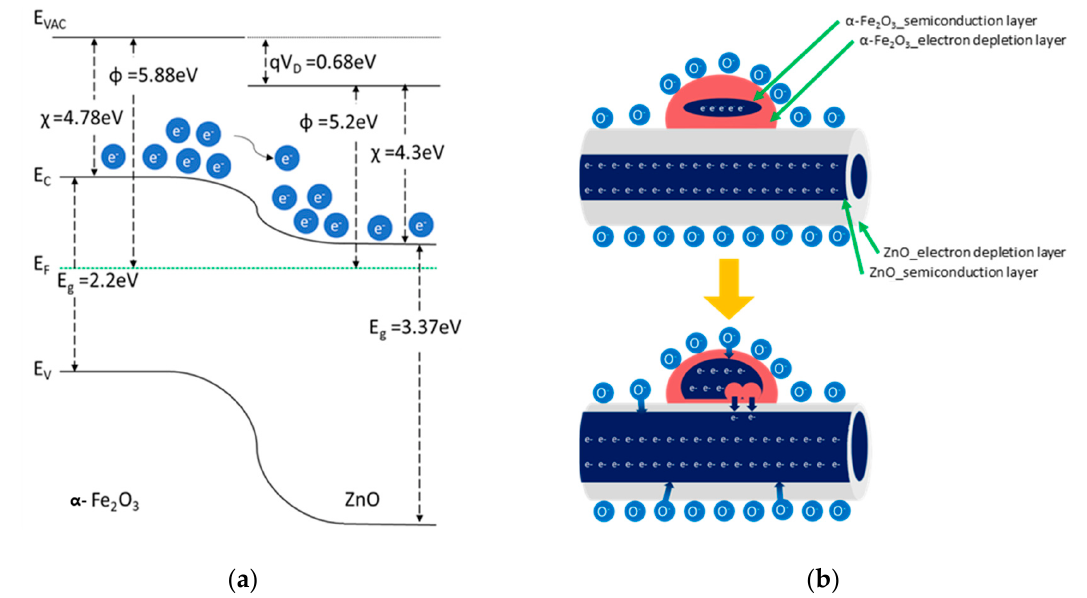
Figure 5. Improvement in gas sensor response: ( a ) energy diagram of α -Fe 2 O 3 / ZnO heterojunction and ( b ) schematics of α -Fe 2 O 3 / ZnO when exposed to a reducing gas.